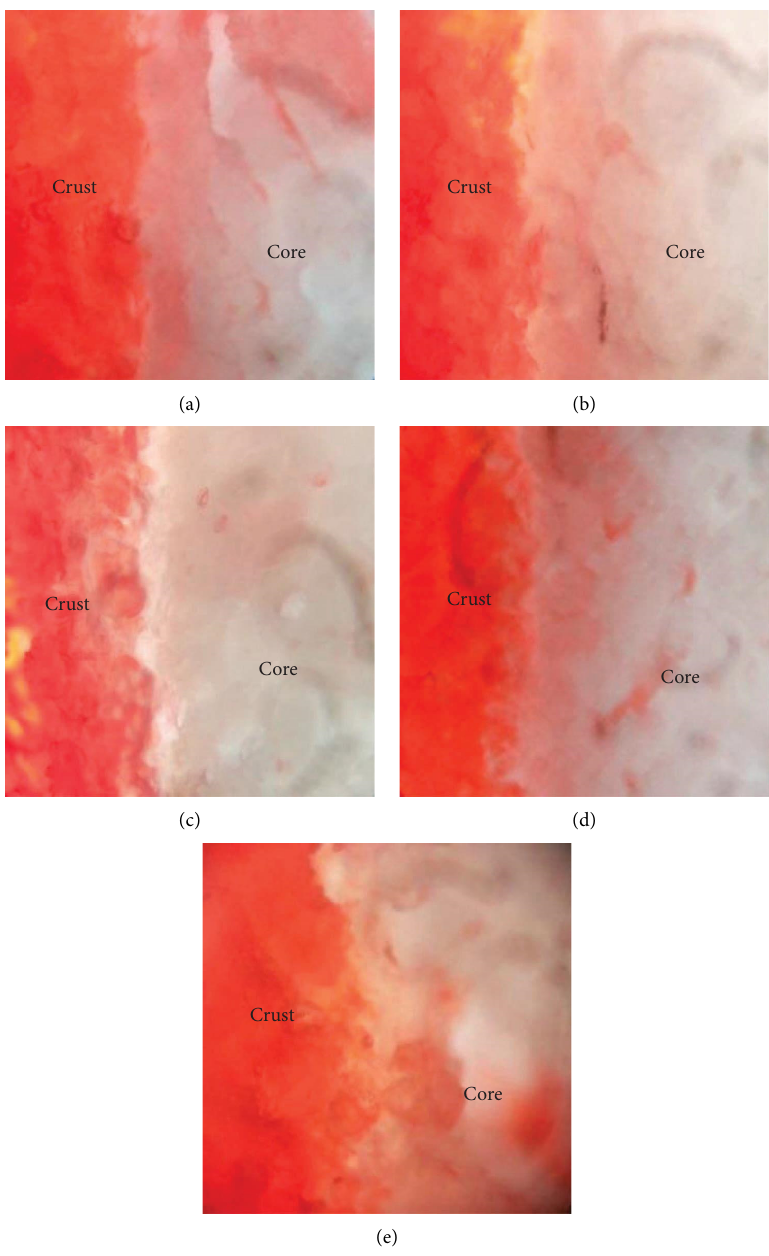
Figure 4: Efect of the WS :WG ratios on oil penetration of fried BBFNs. All the images were taken at 4x magnifcation in refective mode. (a–e) refer to the WS : WG ratios of 15 :1, 13 :1, 11:1, 9:1, and 7:1 w/w,